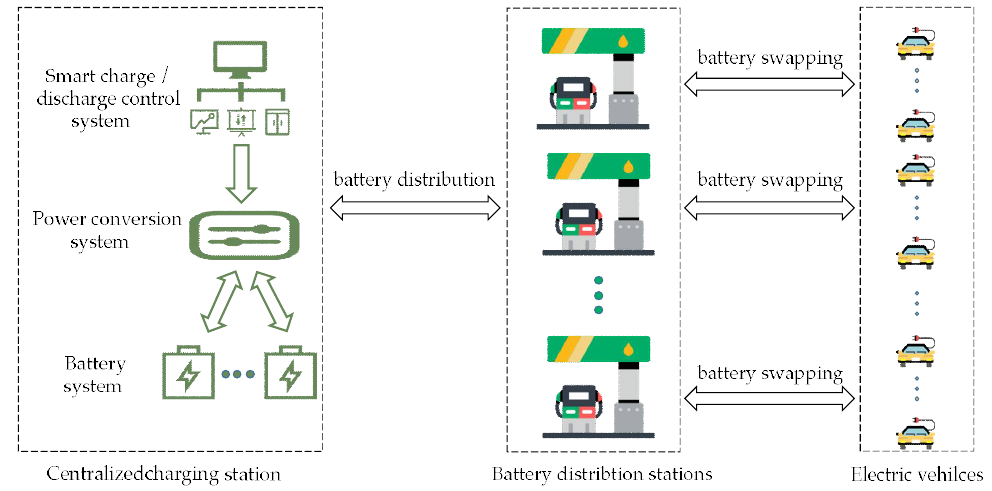
Figure 1. Operational structure of the centralized charging and unified distribution pattern.